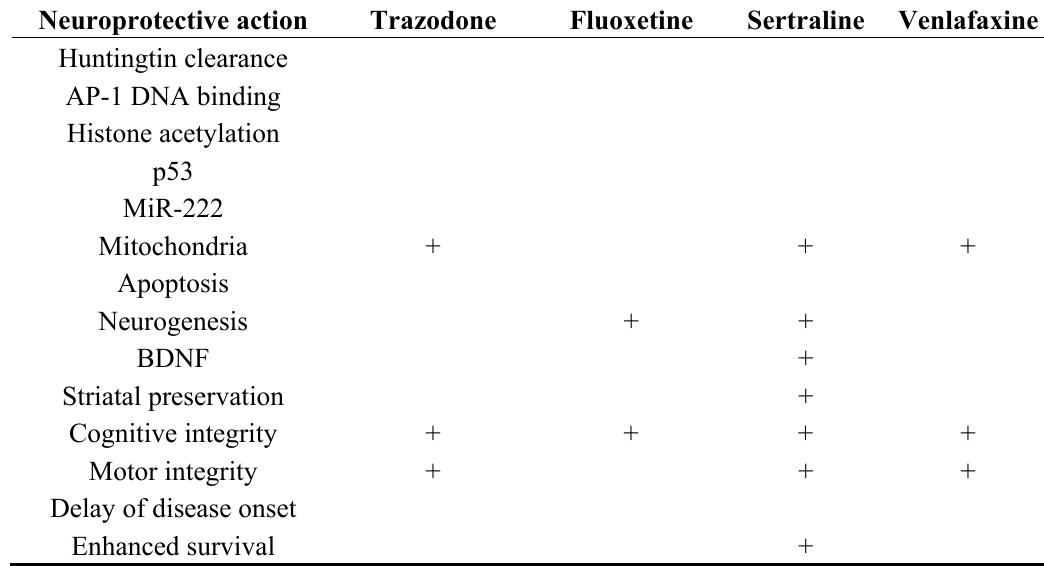
Table 8. Other antidepressant neuroprotective effects in Huntington’s disease models.